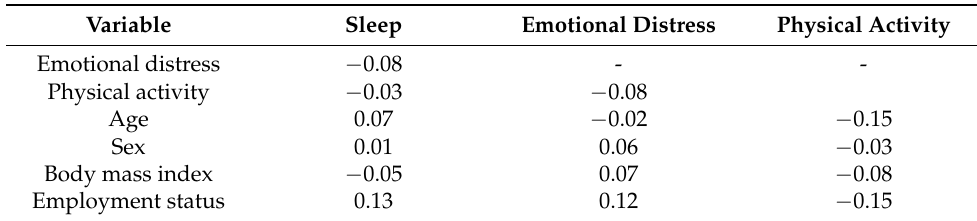
Table 3. Correlations between the relevant variables of interest and covariates for the stratified White population ( n = 227,823).